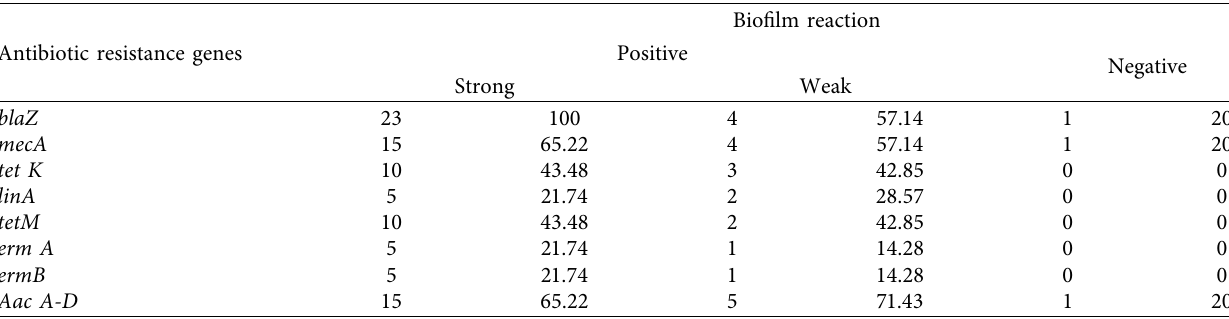
Table 6: Prevalence of antibiotic resistance genes in biofilm-forming and nonforming in S. aureus strains isolated from row cow milk. Antibiotic resistance genes